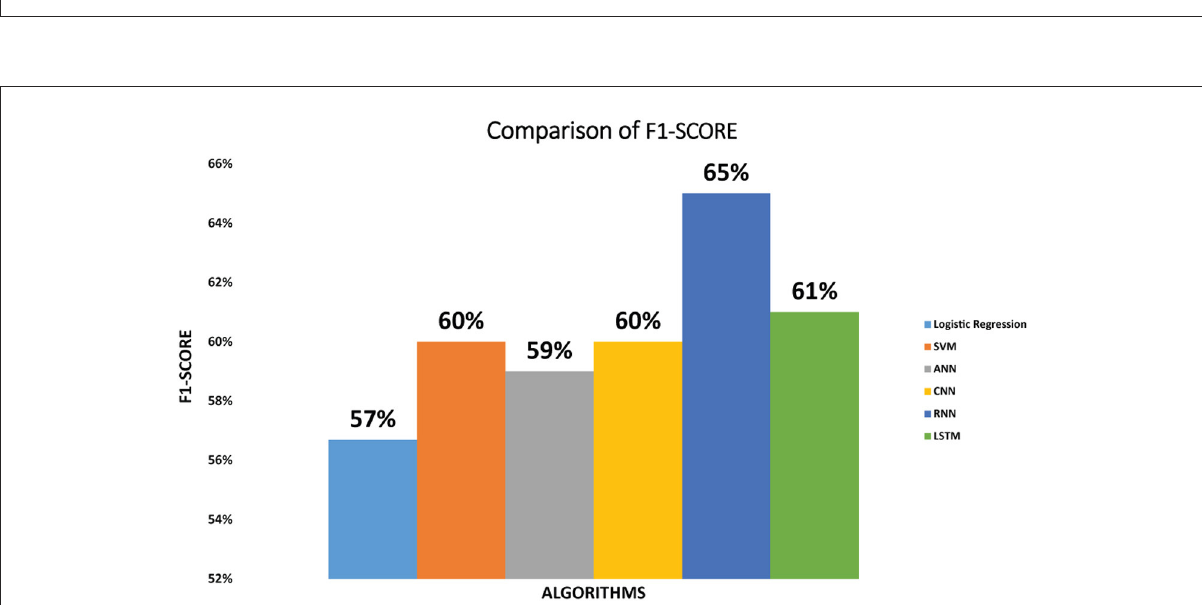
FIGURE5 Comparison of F1-score for logistic regression, SVM, ANN, CNN, RNN, and